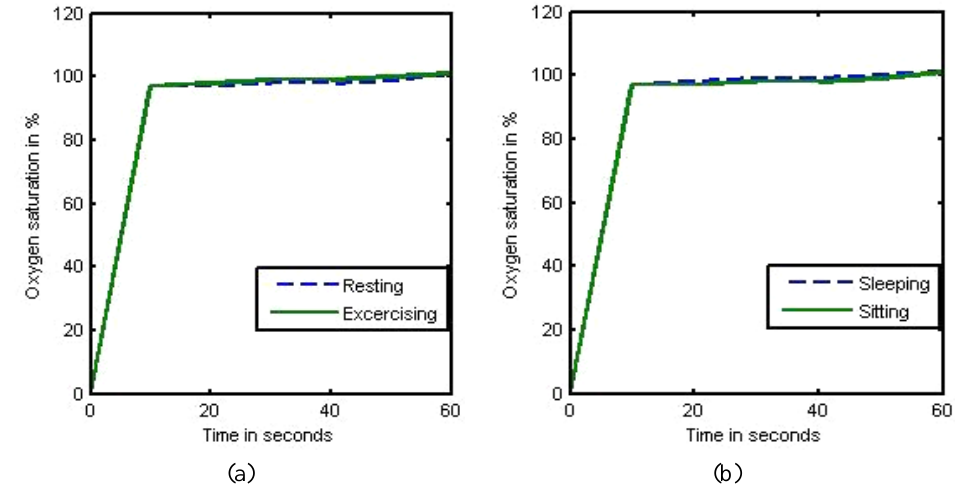
Figure 8. (a) Resting versus exercising, and (b) sleeping versus sitting